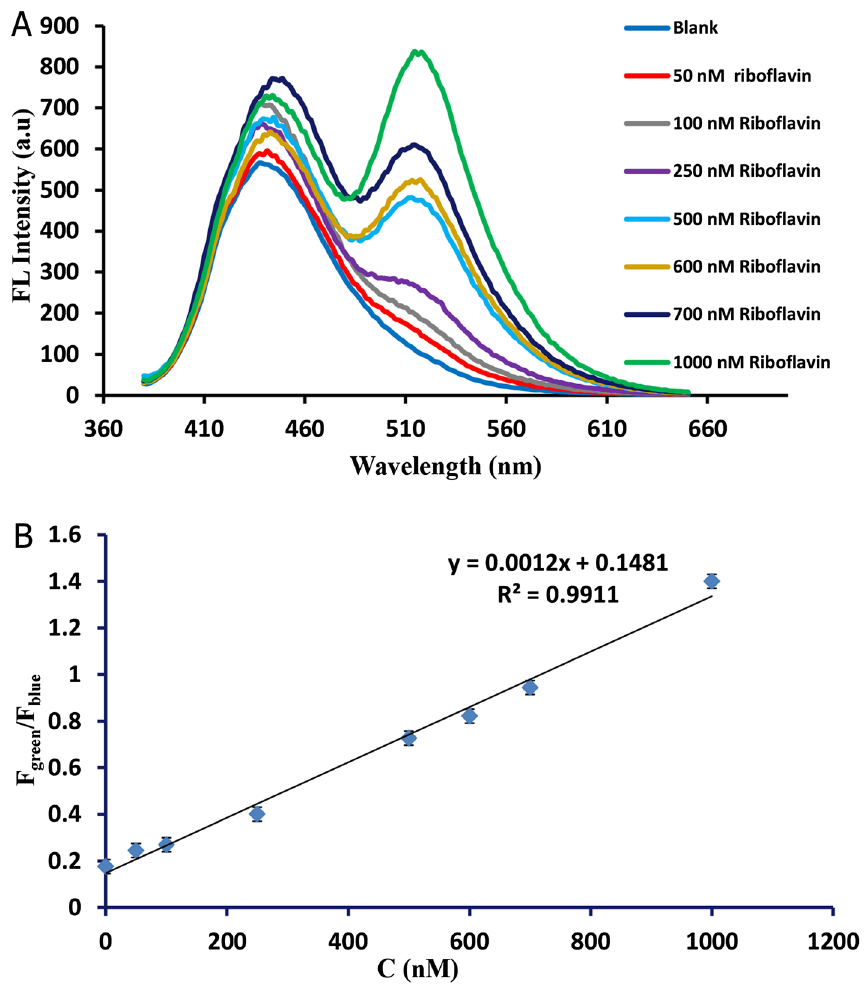
Figure 2. ( A ) The ratio of the relative green to blue emission peaks (F green /F blue ) upon successive addition of riboflavin. ( B ) Linear regression graph of F green /F blue values against riboflavin concentration in the ranges of 50–1000